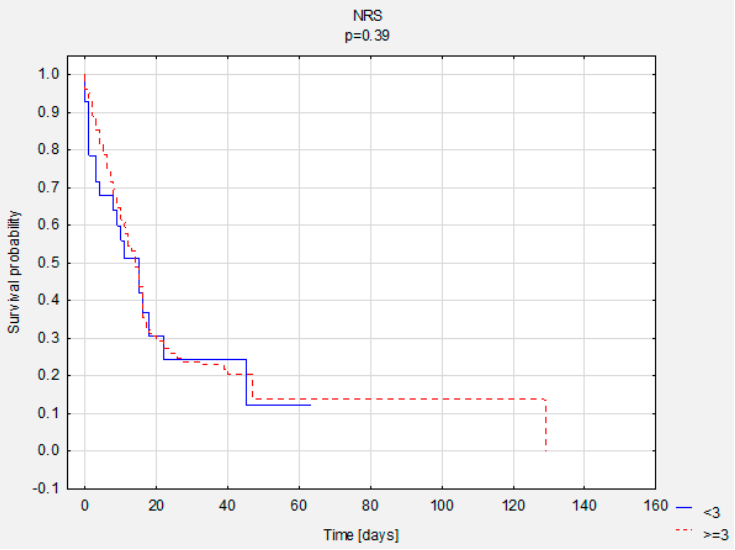
Figure 2. Comparison of survival curves according to BMI scores.